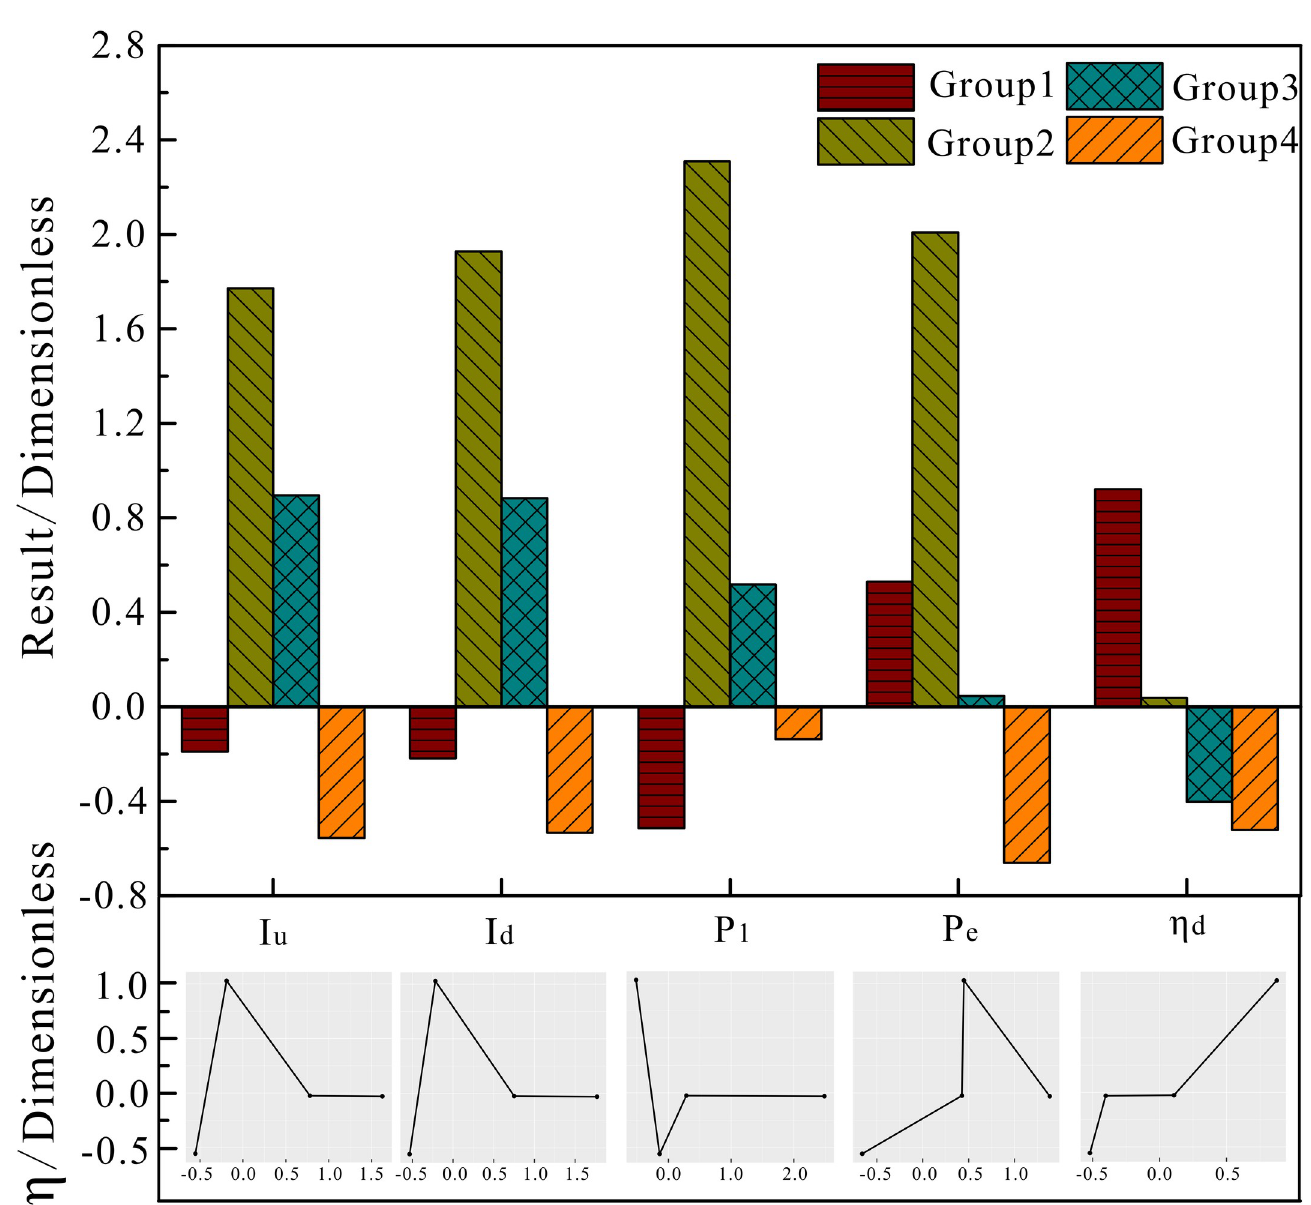
Fig 9. Block motor parameters for the improved algorithm clustering